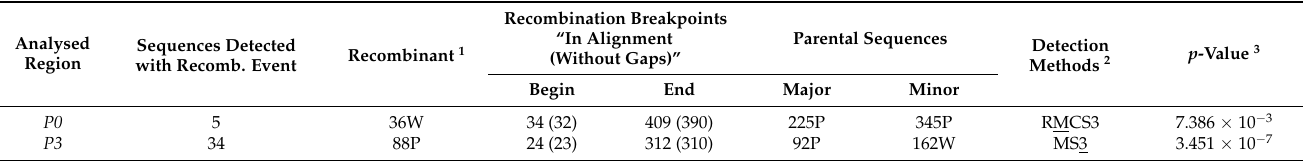
Table 6. Recombination within and between P0 and P3